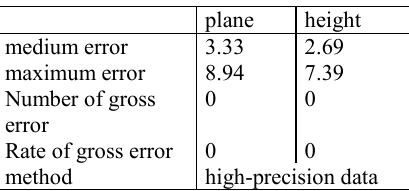
Table 5. Statistical results of field